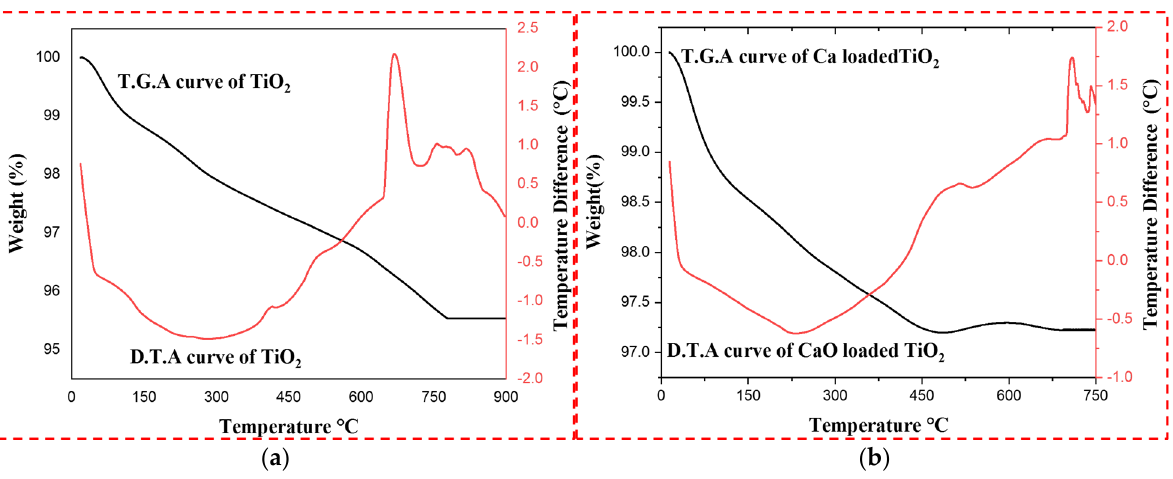
Figure 4. TGA-DTG analysis of ( a ) TiO 2 ( b ) 2% CaO-TiO 2 .